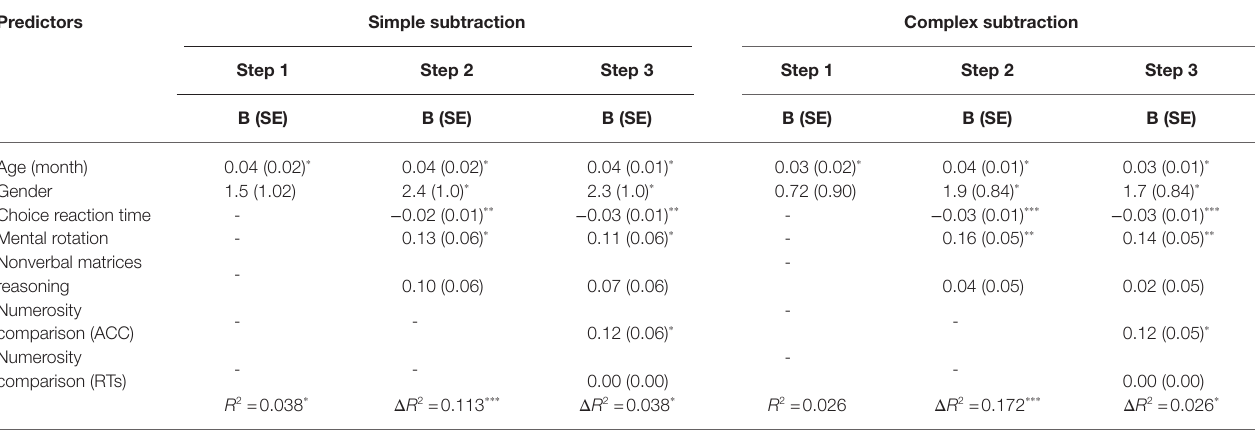
TABLE 3 | Results from hierarchical regression analyses for the relations of numerosity processing and arithmetic computation (simple subtraction and complex subtraction) after controlling for age/gender (setp 1), and general cognitive processes (step 2). Predictors